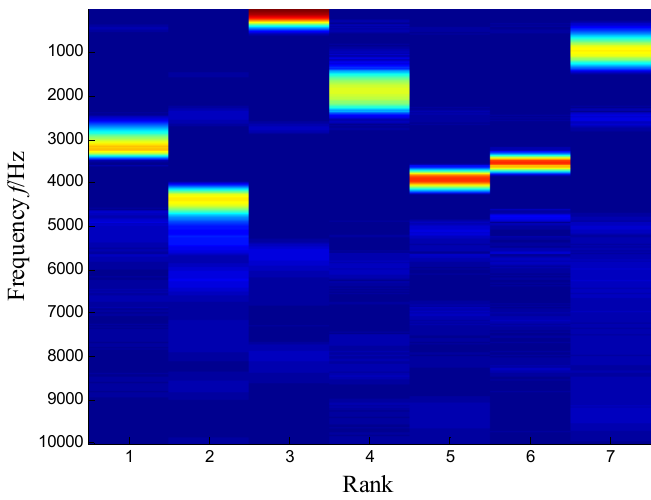
Figure 4. Time–frequency distribution of the outer race defect.